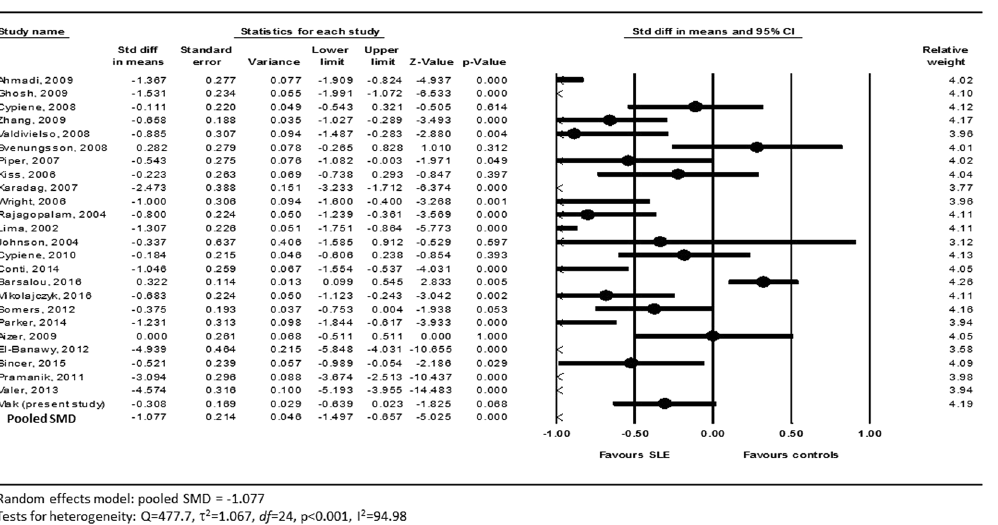
Figure 2. Forest plot of the primary outcome of